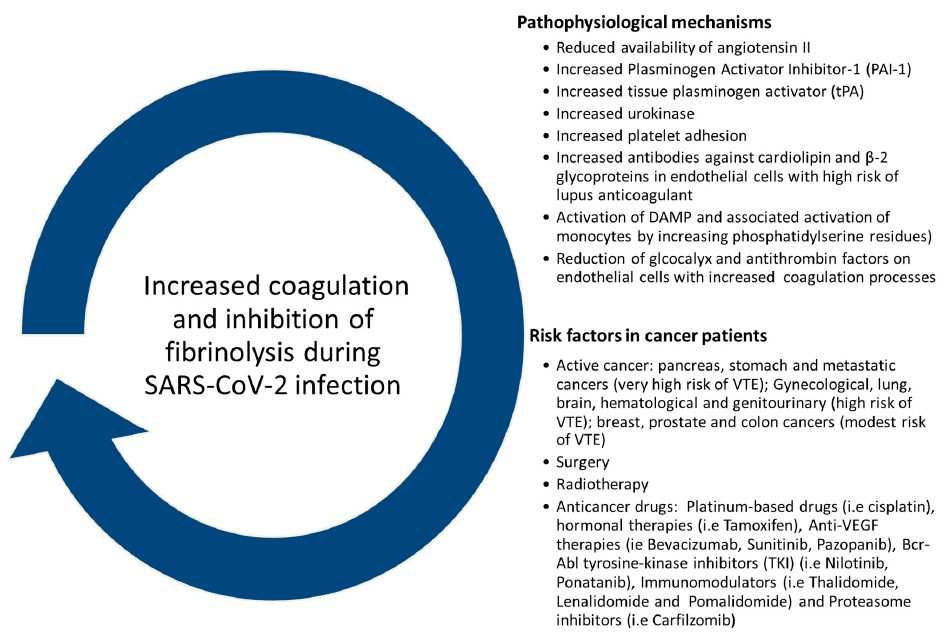
Figure 4. Pathophysiological mechanisms related to the coagulation dysfunctions in patients